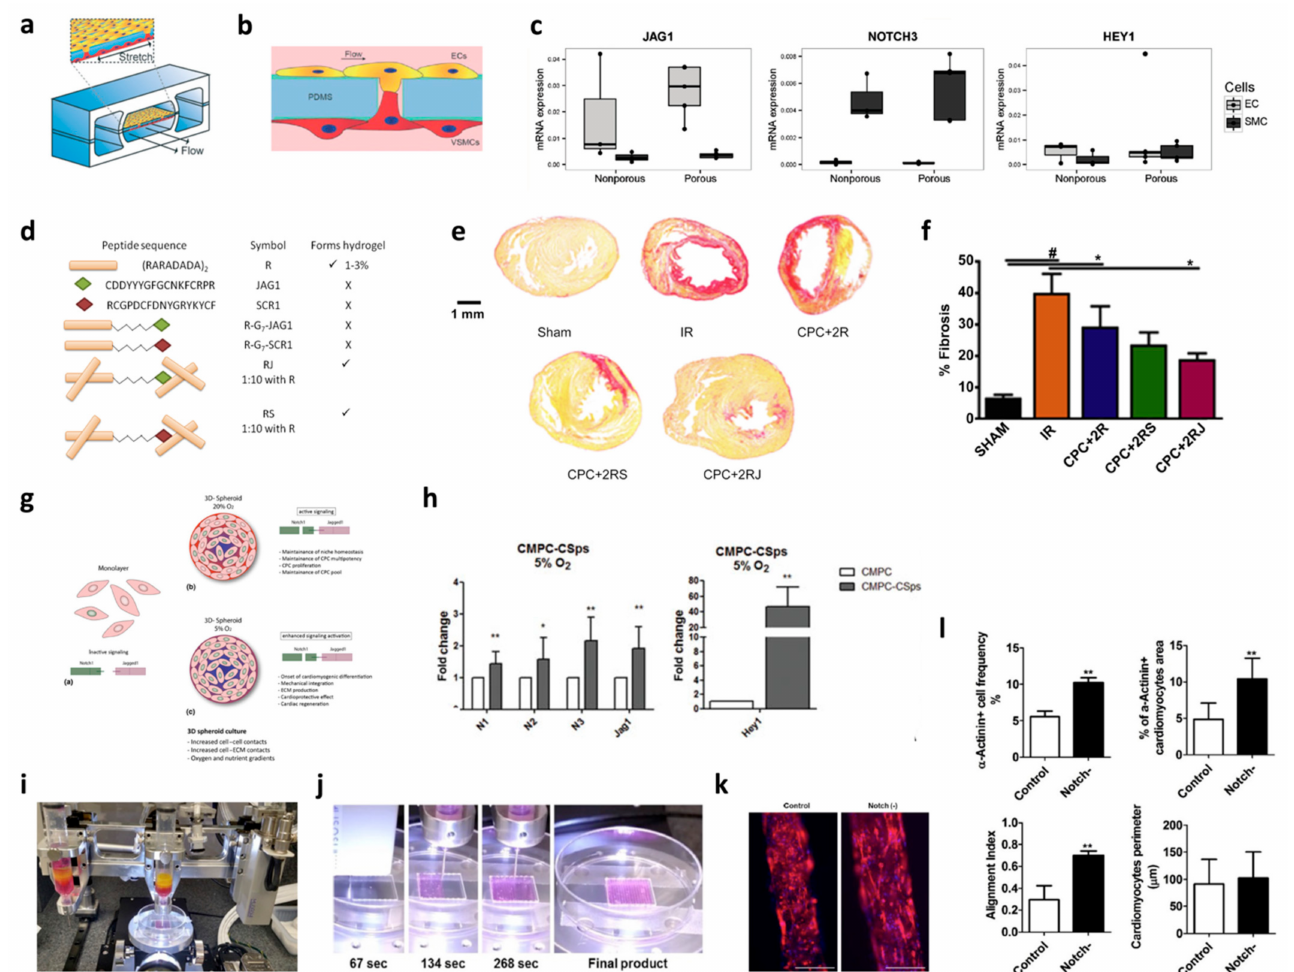
Figure 2. Modeling Notch signaling in various bioengineering systems. Microfluidics system: ( a ) ECs-VSMCs physiological microfluidic design; ( b ) ECs-VSMCs interaction via pores; ( c ) expression of Notch3, Jag1, and Hey1 in ECs and VSMCs [76]. Reproduced with permission from [Nicole C. A. van Engeland et al.,], [Lab Chip]; published by [Royal Society of Chemistry], (2018). Hydrogel : ( d ) Composition of hydrogels with and without Jag1; ( e , f ) Comparison of fibrosis formation with various hydrogels, * p < 0.05, ** p < 0.01, # p < 0.001 [82]. Reproduced with permission from [Archana V. Boopathy et al.,], [Biomaterials]; published by [Elsevier], (2014). Spheroid : ( g ) Representation of Notch signaling in monolayer and 3D spheroid conditions; ( h ) expression of Notch1, Notch2, Notch3, Jag1, and Hey1 between monolayer culturing (CMPC) and 3D spheroid culturing (CMPC-CSps under hypoxia conditions), * p < 0.05, ** p < 0.01 [84]. Reproduced with permission from [Arianna Mauretti et al.,], [MRS Communications]; published by [Springer Nature], (2017). 3D bioprinting: ( i ) Custom 3D bioprinter containing three components for cardiac construct; ( j ) interval image sequence of cardiac tissue construct formation; ( k ) comparison of bioprinted tissue construct with and without Notch inhibition; ( l ) Measurement of α -actinin positive cells, cardiomyocyte area, alignment of cardiomyocytes, and cardiomyocyte perimeter among control and Notch inhibition tissue constructs for cardiac tissue development, ** p < 0.05 compared with control [91]. Reproduced with permission from [Zhan Wang et al.], [Acta Biomaterialia]; published by [Elsevier],